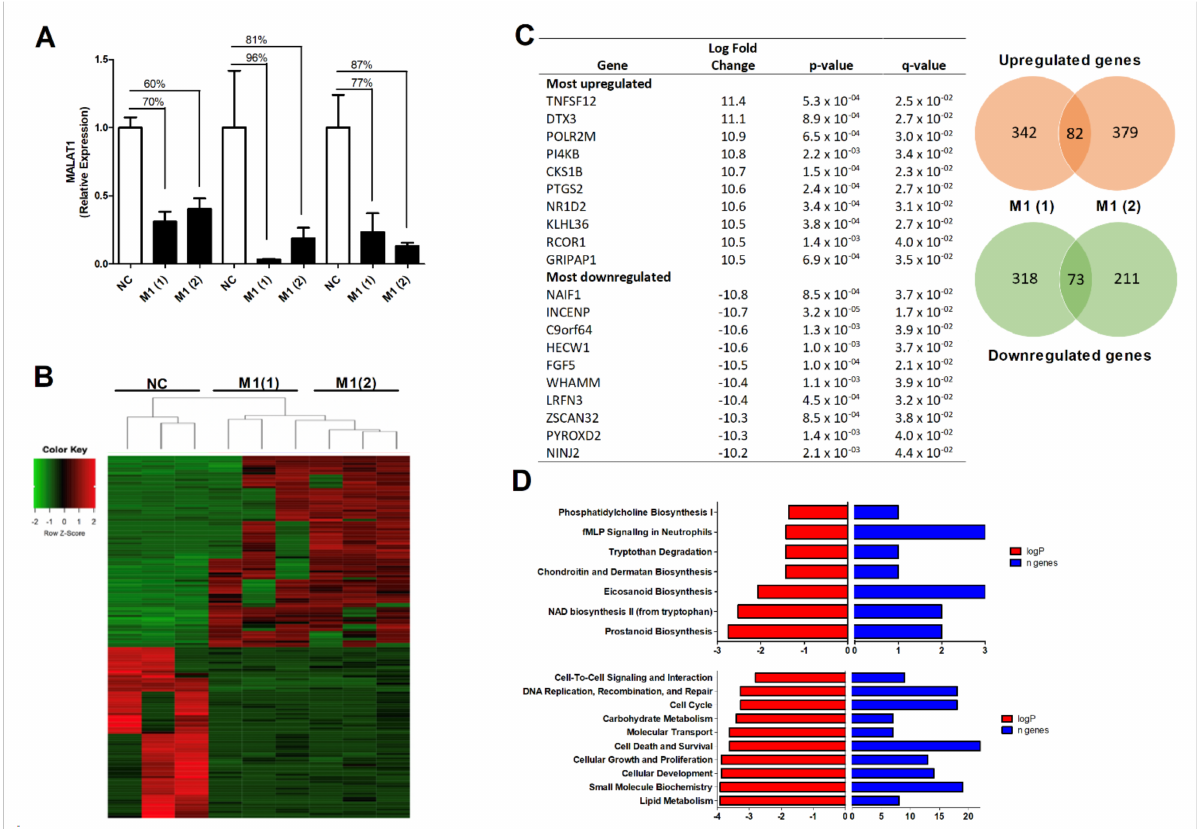
Figure 2. The effect of MALAT1 knockdown on the OA osteoblast transcriptome. ( A ) Knockdown of MALAT1 expression in primary OA osteoblasts. Osteoblasts were transfected with either a non-targeting control LNA (NC) or one of two LNAs targeting MALAT1 , M1(1) and M1(2). Expression of MALAT1 was determined by qPCR 24 h after transfection and normalised to 18S. ( B ) Heatmap of differentially expressed genes (>1.5-fold, p < 0.05) as determined by RNAseq (Quantseq) following 24 h LNA-mediated MALAT1 knockdown. ( C ) Table of the most upregulated and down-regulated genes following MALAT1 knockdown, with Venn diagram illustrating the total numbers of genes differentially expressed (>1.5-fold, p < 0.05) with each of the MALAT1 LNAs. Values represent the mean fold change between control LNA and MALAT1 (1) LNA and between control LNA and MALAT1 (2) LNA. ( D ) Top canonical pathways and cellular processes as determined by Ingenuity Pathway Analysis of the differentially expressed genes (fold change > 1.5, p < 0.05) following MALAT1 knockdown, with logP values representing the significance between the pathway/process and the gene dataset and n representing the numbers of genes within the dataset aligned to the